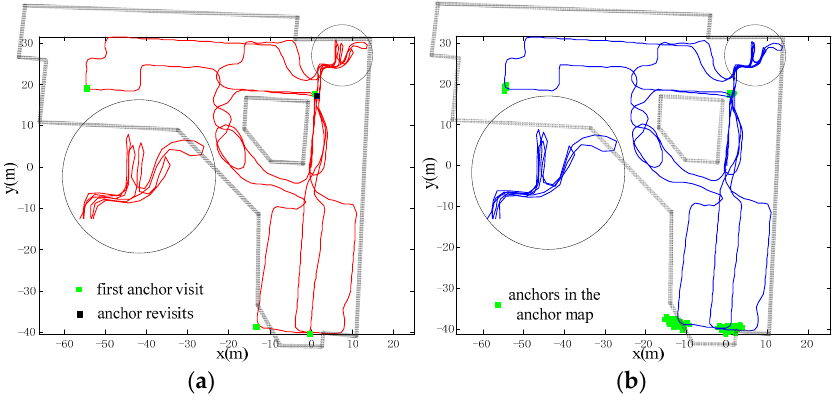
Sensors 2016 , 16 , 334 14 of 18 3.